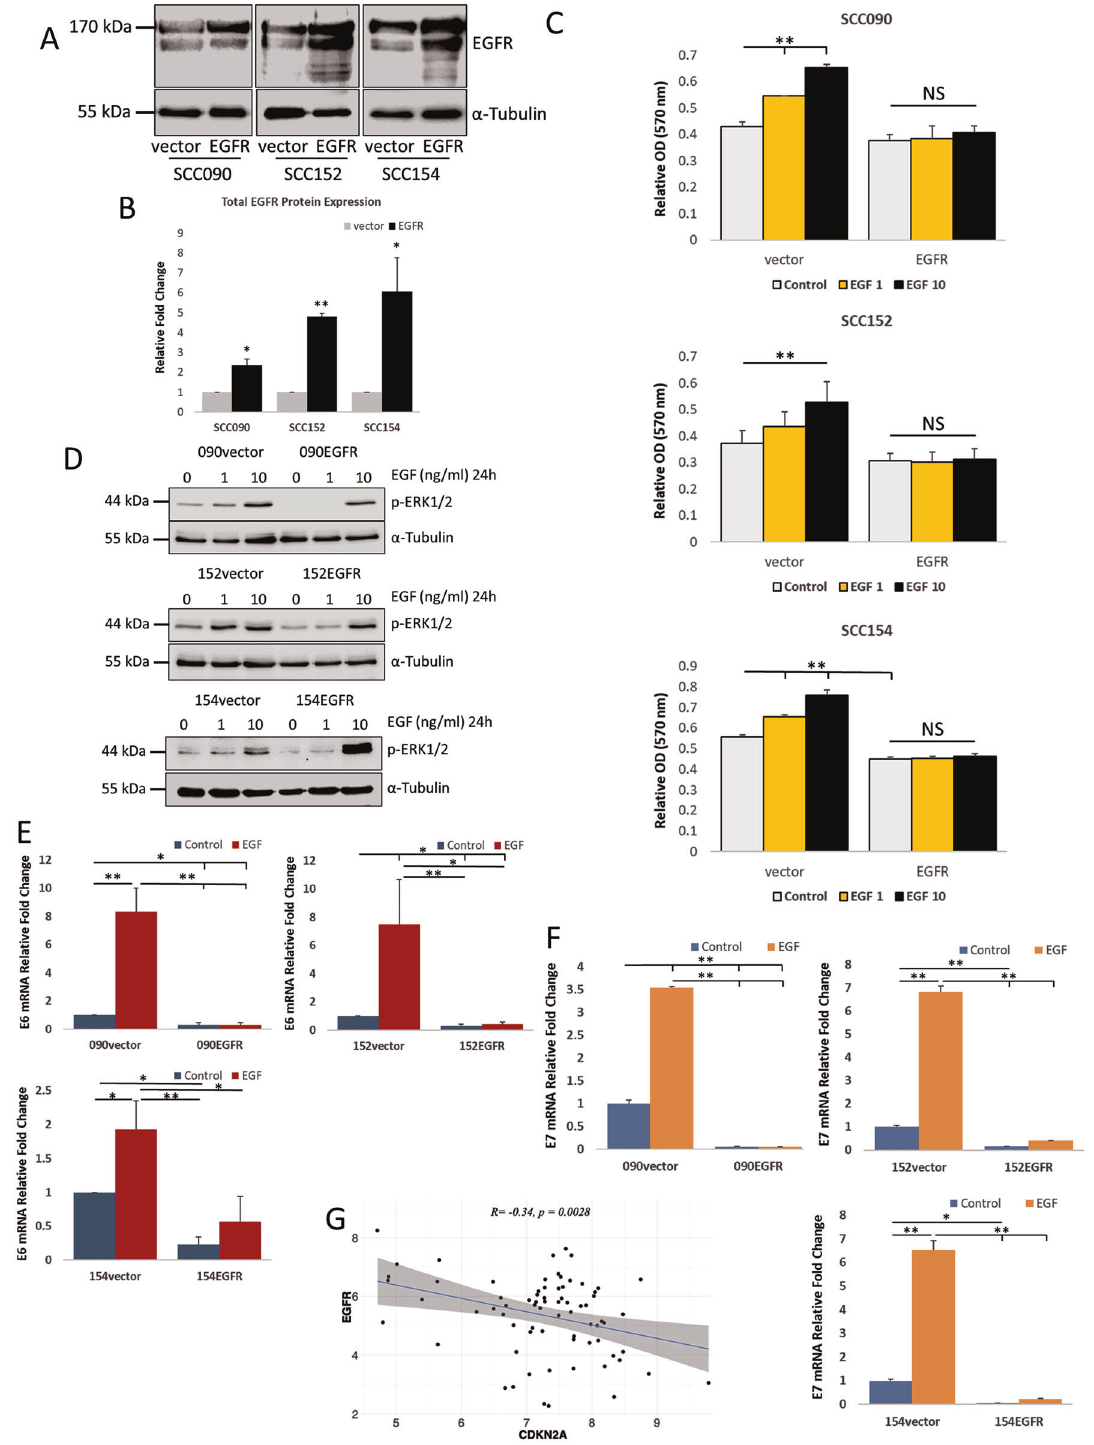
Fig. 1 Effects of EGFR overexpression and EGF treatment in HNSCC cells. A EGFR expression in SCC090, SCC152 and SCC154 in EGFR- overexpressing cells and their control counterparts. B Quanti fi cation of three independent experiments of EGFR overexpression presented in bar-chart. Band intensities were adjusted for the intensities of the loading control bands then normalised using the control value, independent t test (* p < 0.05, ** p < 0.01). C Cell proliferation measured by MTT at 72 h after EGF treatment (EGF 1 – 1 ng/ml; EGF 10 – 10 ng/ml) in vector control and EGFR-overexpressing cells. Statistical analysis was performed using two-way ANOVA with Tukey post hoc test (* p < 0.05, ** p < 0.01). The full growth curve can be found in Supplementary Figure S1A. D Levels of phosphorylated ERK1/2 expression in EGFR- overexpressing SCC090, SCC152 and SCC154 cells and their control counterparts after EGF treatment at indicated concentrations for 24 h. HPV E6 ( E ) and HPV E7 ( F ) transcription after 10 ng/ml EGF treatment for 24 h measured by qRT-PCR in three independent RNA extractions. Statistical analysis was performed by one-way ANOVA (* p < 0.05, ** p < 0.01). G Estimated Pearson correlation factor (R) for CDKN2A vs EGFR at mRNA levels in HPV-positive HNSCC samples from the TCGA database (GSE_62944_06_01_15_TCGA_24).